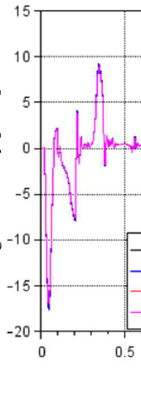
values. The first cycle of the :